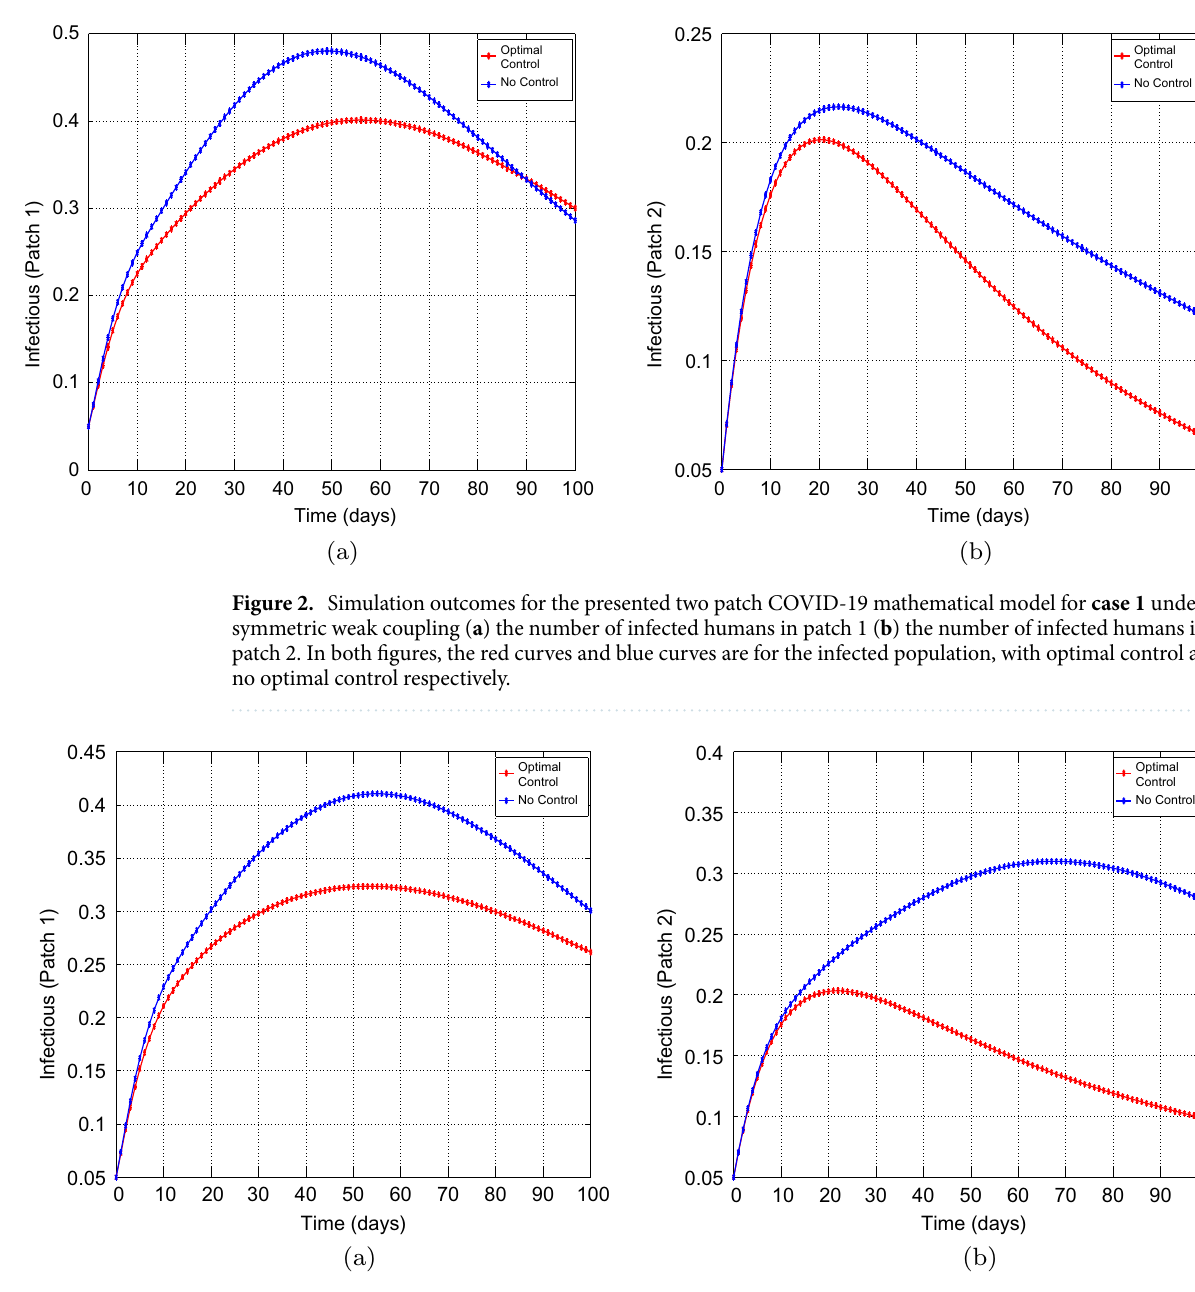
Figure 3. Simulation outcomes for the presented two patch COVID-19 mathematical model for case 1 under symmetric strong coupling ( a ) the number of infected humans in patch 1 ( b ) the number of infected humans in patch 2. In both figures, the red curves and blue curves are for the infected population, with optimal control and no optimal control